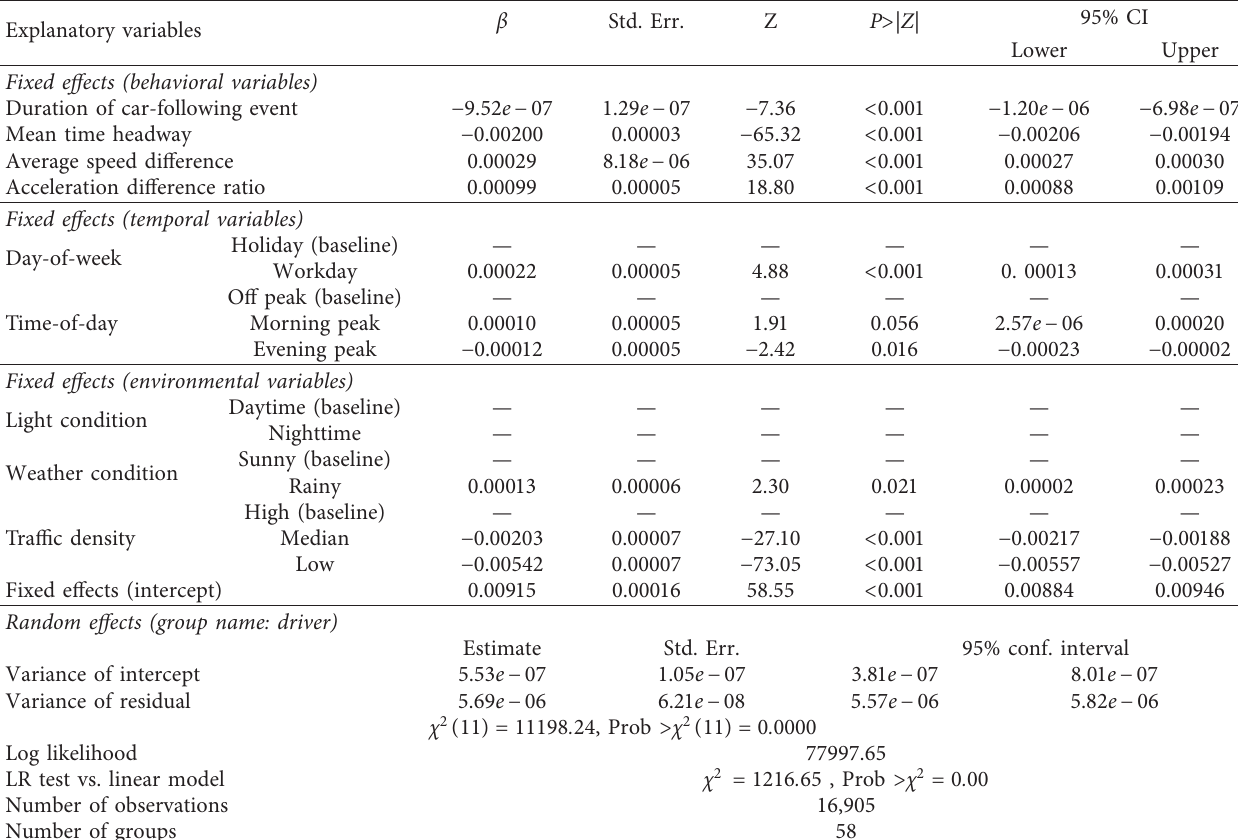
Table 6: Estimated parameters of the the mixed-effects linear regression